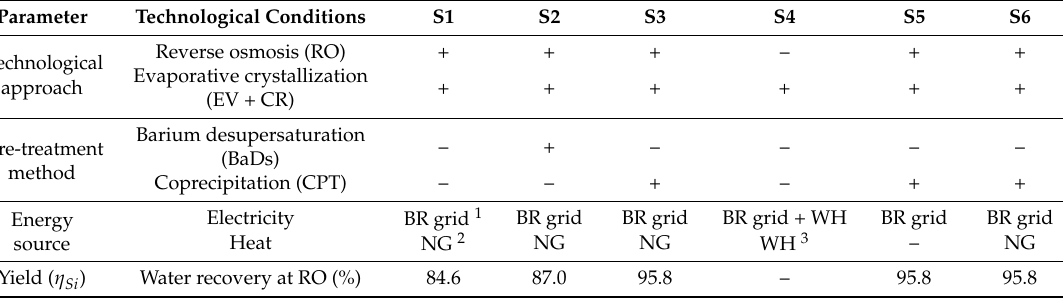
Table 2. Technical characteristics and energy sources for each